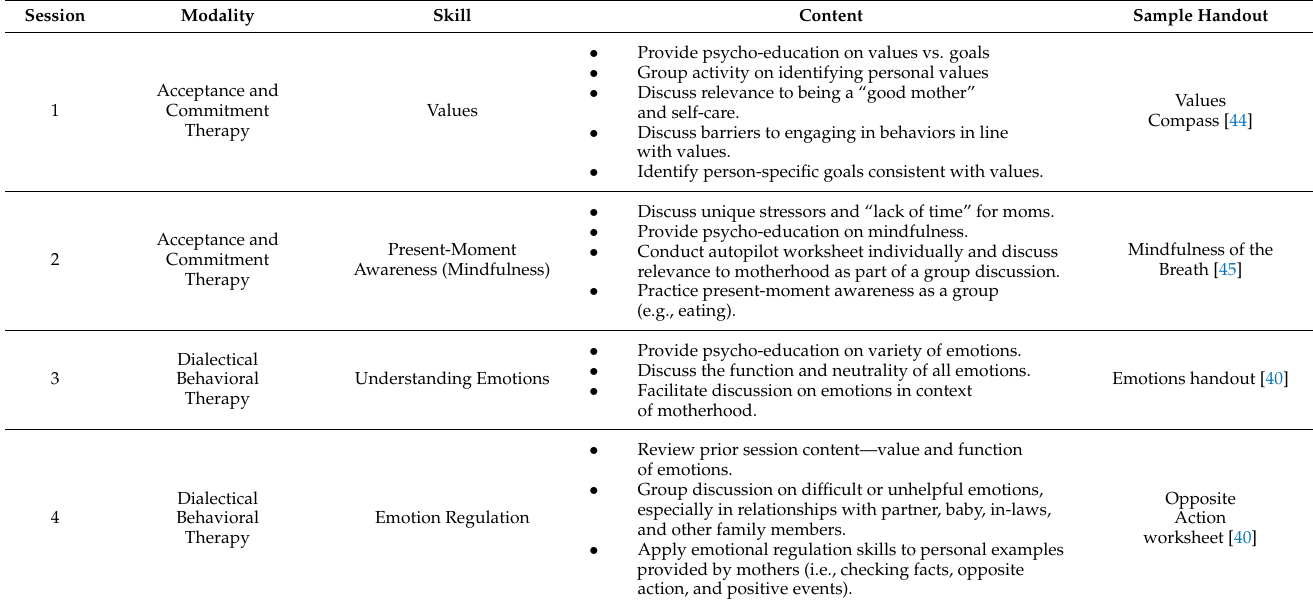
Table 1. Session outline of the “ Motherhood and Me (Mom-Me) ”